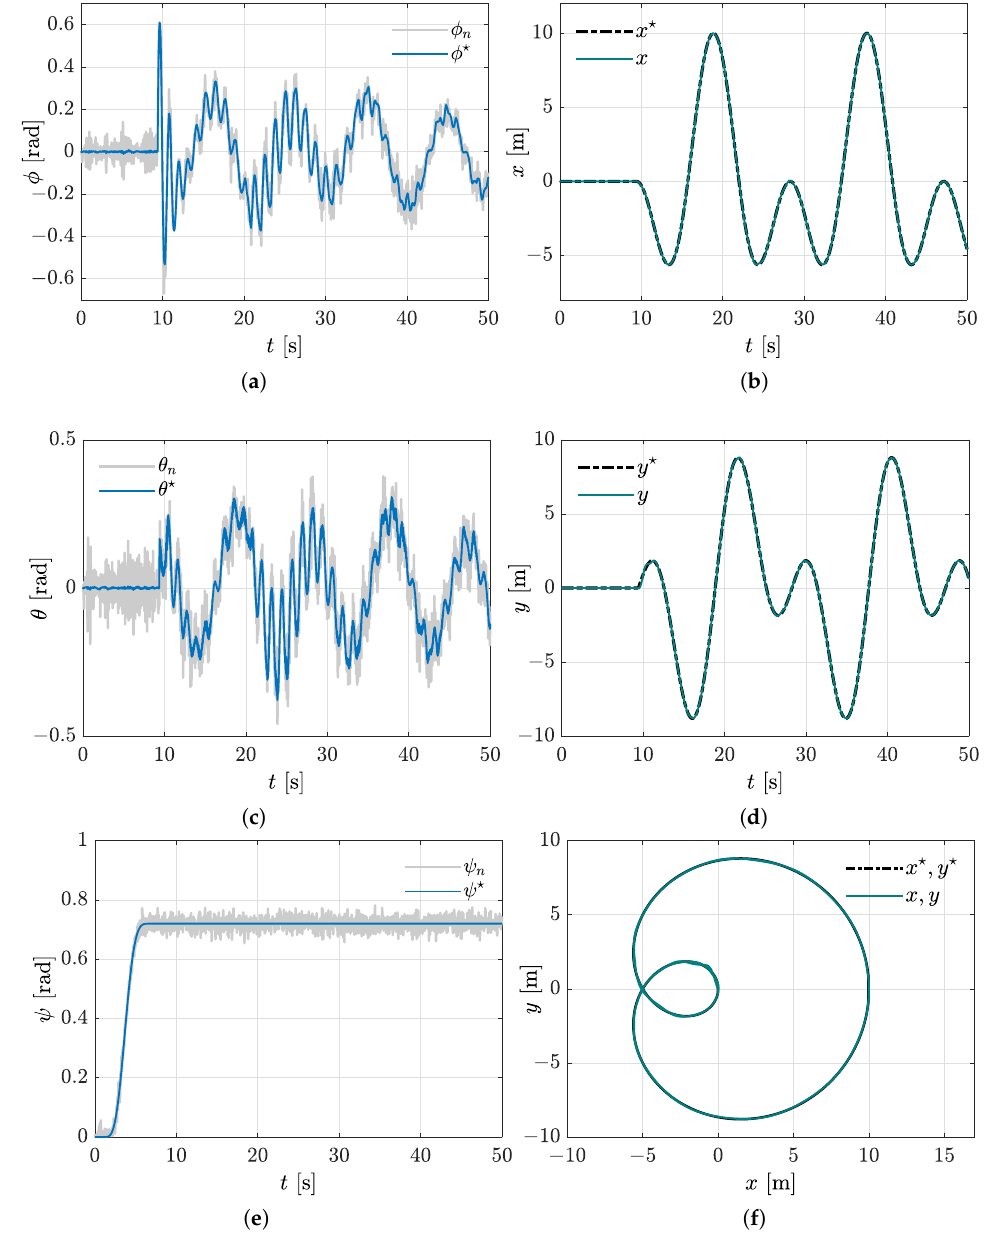
Figure 19. Noisy sensor measurements in motion control, case 2.4. ( a ) Tracking of the desired φ angle. ( b ) Tracking of the desired x position. ( c ) Tracking of the desired θ angle. ( d ) Tracking of the desired y position. ( e ) Tracking of the desired ψ angle. ( f ) Horizontal plane path